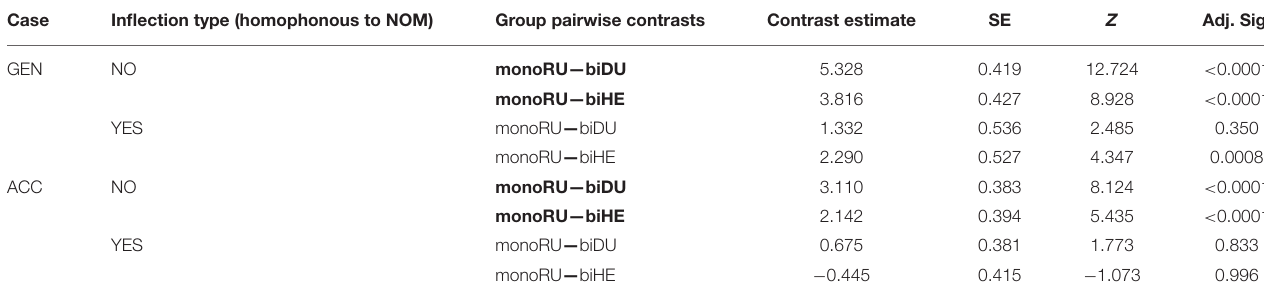
TABLE 4 | Pairwise contrasts for group comparisons (monoRU vs. biDU, monoRU vs. biHE) per case per inflection type. Case